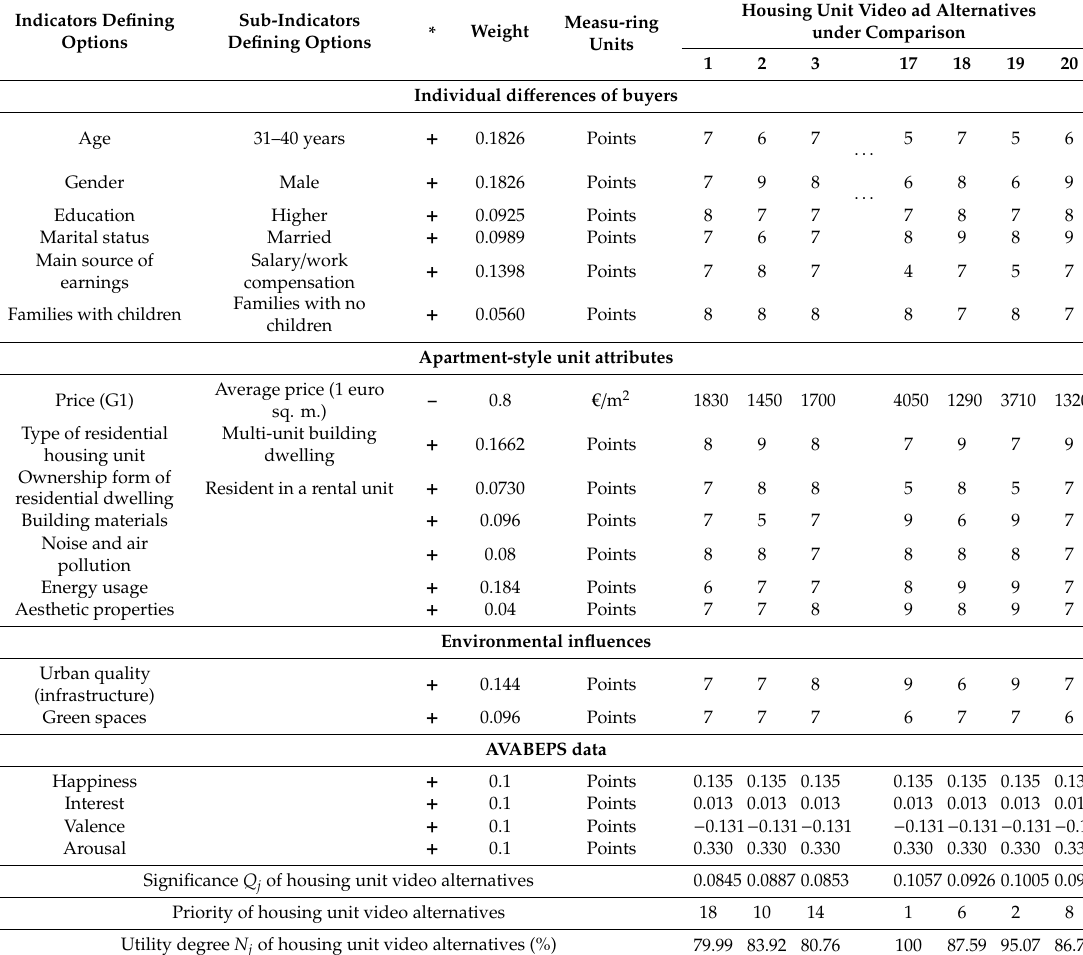
Table 7. Sum neuro housing decision matrix compiled during the Old Town second-stage